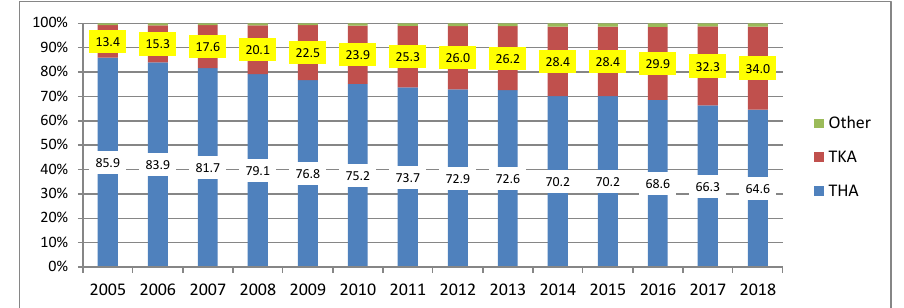
Figure 3. Percentage of individual types of joint replacement surgeries performed in Poland in 2005–